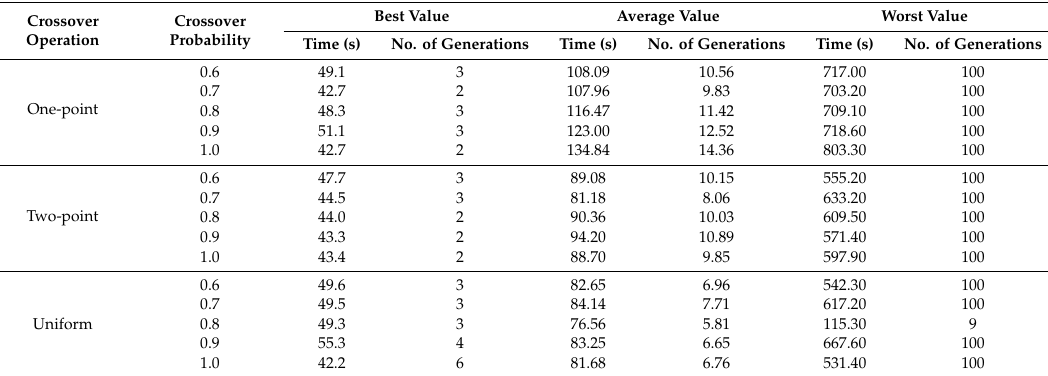
Table 5. E ff ect of crossover operator for test case generation using the MSGA.